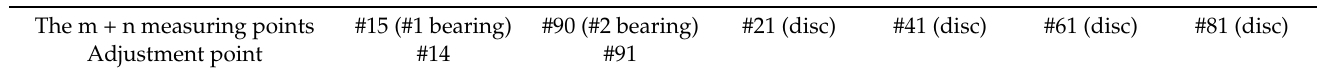
Table 4. The measuring points for g1.4.